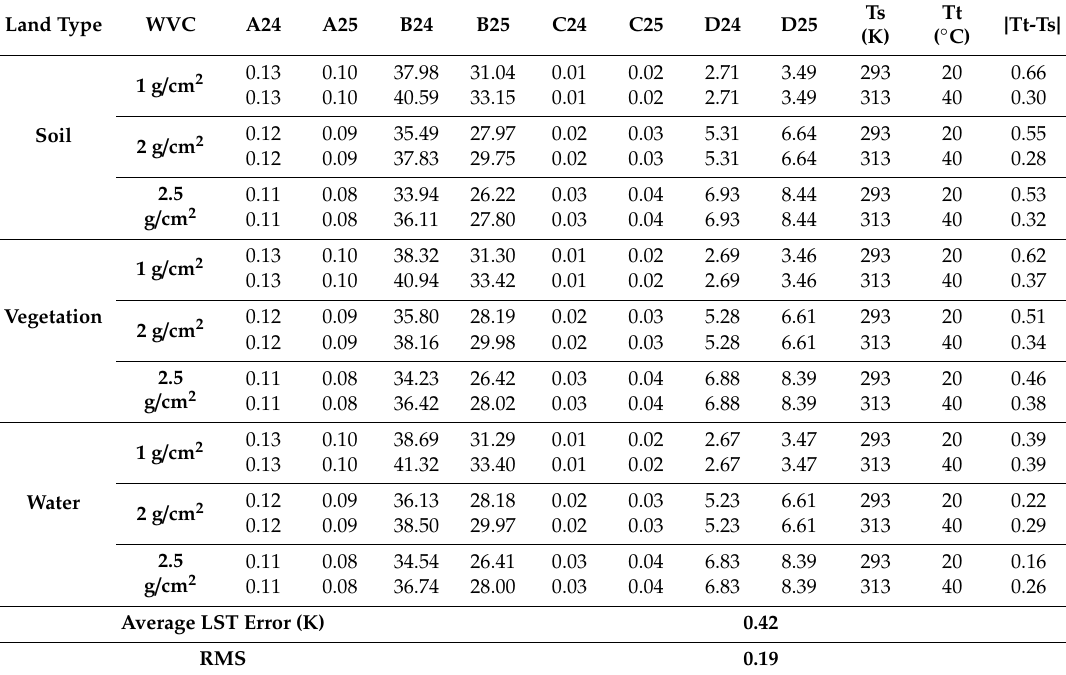
Table 5. The retrieval results from the SW algorithm (transmittance calculated by a polynomial model). Land Type